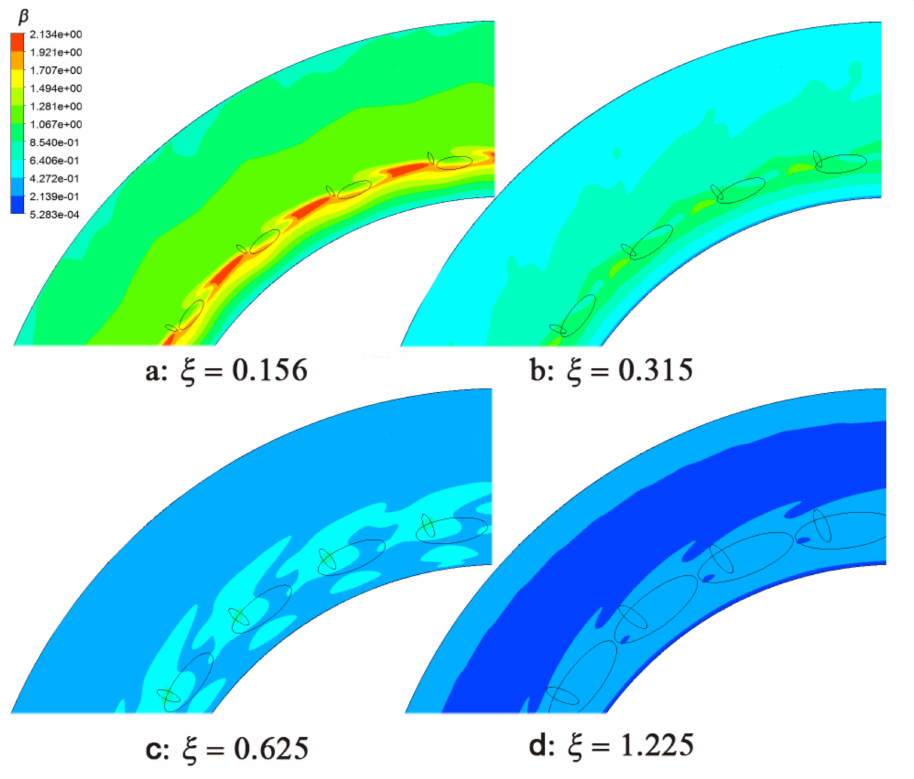
Figure 13. Contour of swirl ratio β at plane z = 0.5 for different area ratios of nozzles to holes: